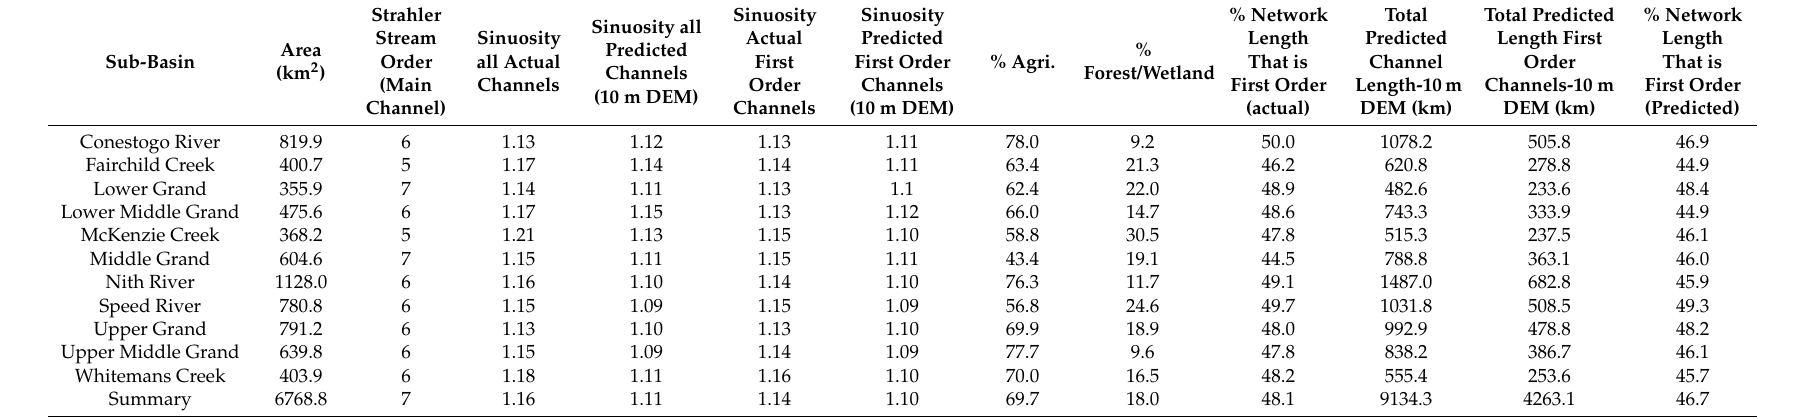
Table 3. Analysis of stream network and land use in major sub-basins in the Grand River